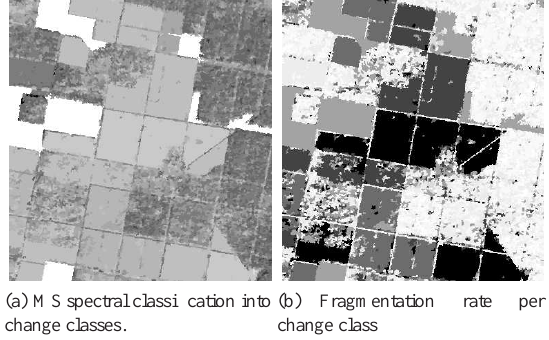
Figure 7: MS spectral classification and fragmentation rate